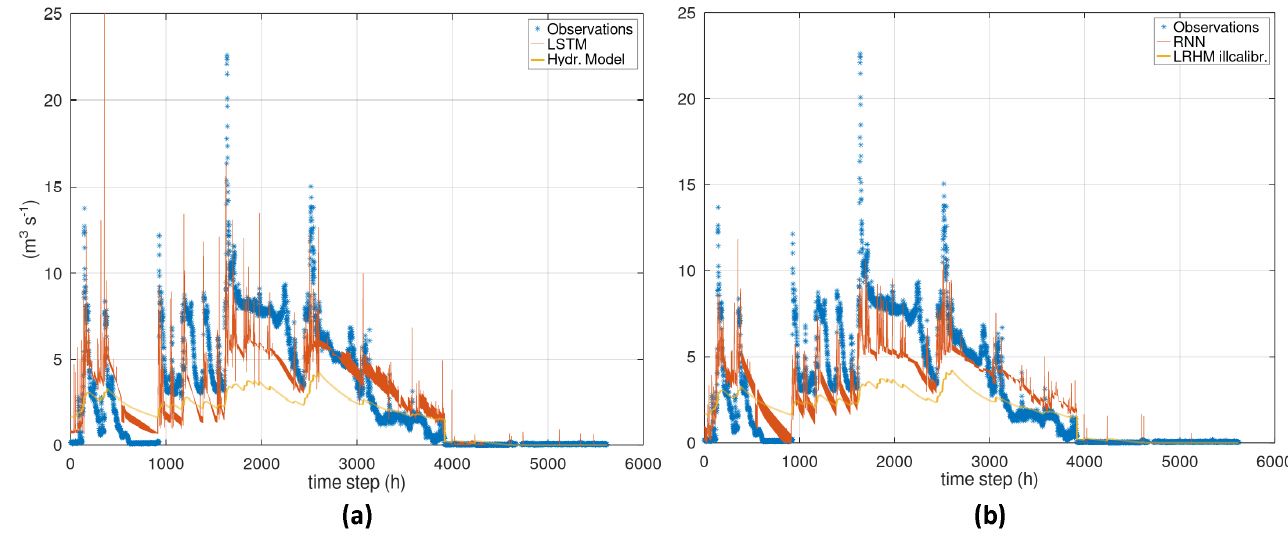
Figure 8. Assessment of the ill-calibrated hydrological model LRHM in Bakas. LSTM ( a ) and RNN ( b ) employed to approximate the best model that can be obtained with the available data during the test period.